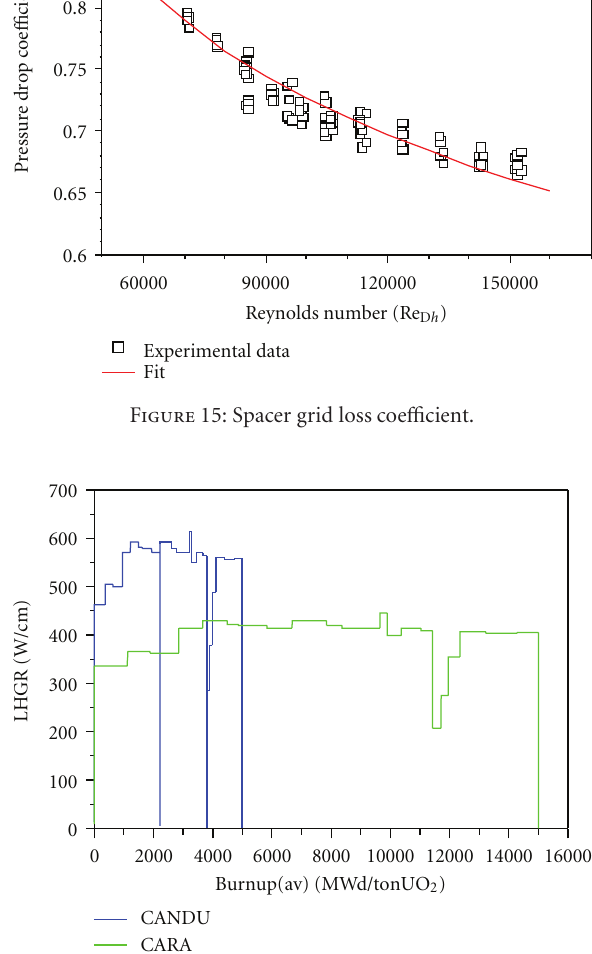
Figure 16: Averaged power history for a CANDU fuel rod and CARA fuel in CANDU.